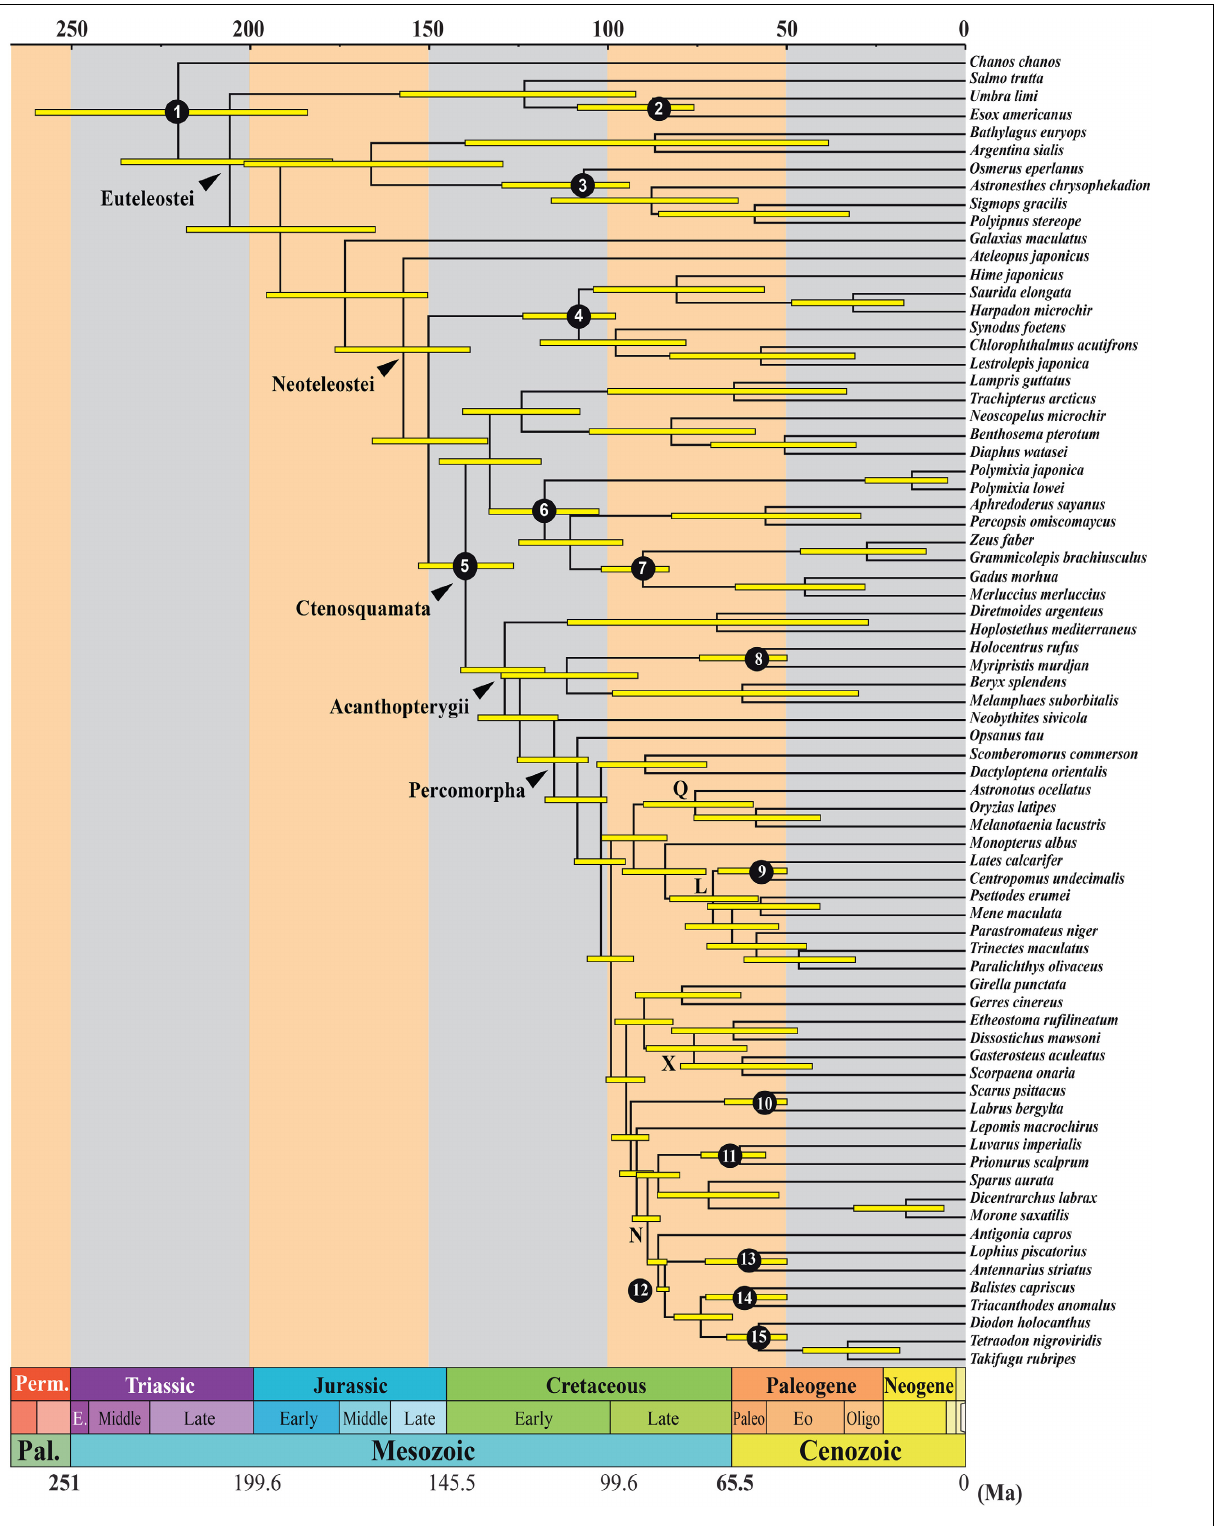
FIGURE 2 | Time-calibrated phylogenetic tree of acanthomorphs and related lineages obtained when each of the nine loci is treated as an individual partition and a fossil prior is applied to the root. Nodes whose minimum age and soft upper bound were estimated using fossil